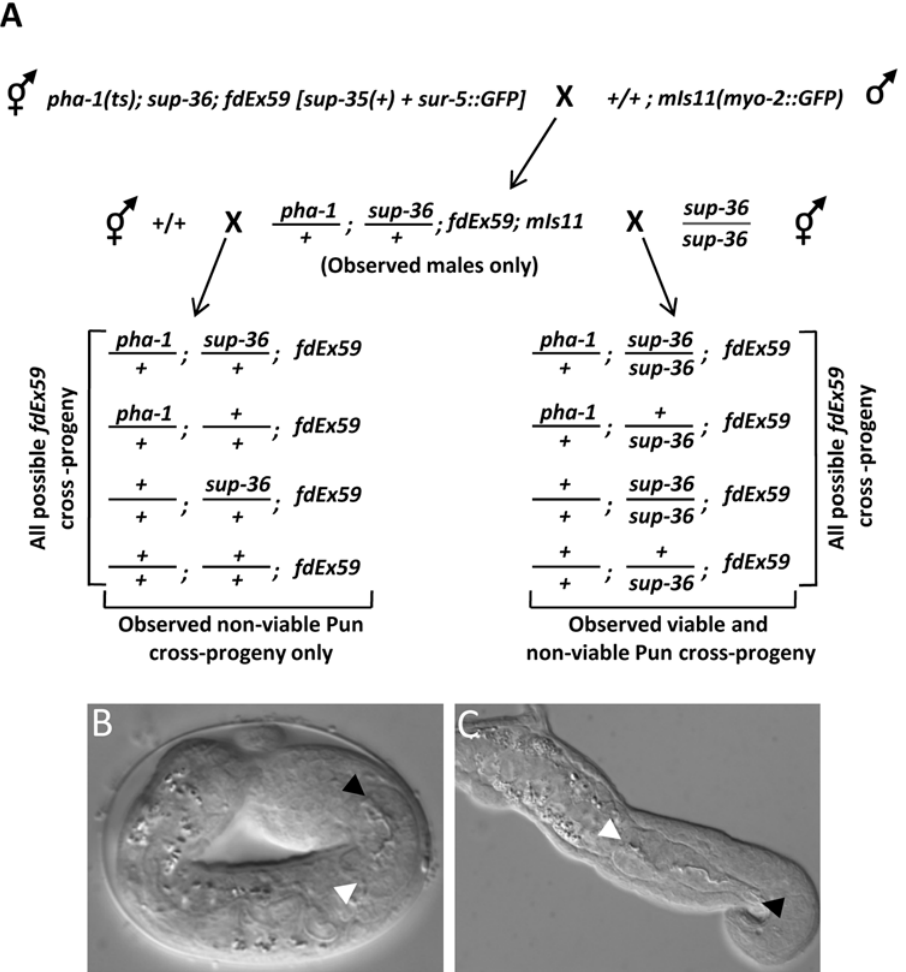
Figure 5. SUP-35 overexpression phenocopies pha-1 loss of function. (A) Representative genetic strategy applied to assay the effects of SUP- 35 overexpression in wild type and in sup-36 and sup-37 mutant backgrounds. Wild-type males carrying an integrated myo-2 ::GFP reporter ( mIs11 ) were crossed into pha-1 ; sup-36 hermaphrodites carrying a sup-35 -overexpressing extrachromosomal array (fdEx59) . Although this mating failed to produce viable F1 cross-progeny hermaphrodites, fertile cross-progeny males were generated, which were identified by expression of the myo-2 ::GFP reporter. F1 cross-progeny males were then mated to wild-type or sup-36 hermaphrodites, and cross-progeny were identified based on the myo- 2 ::GFP reporter. Mating into the N2 strain failed to produce viable cross-progeny males or hermaphrodites, whereas mating to sup-36 generated both viable and non-viable male and hermaphrodite F2 cross-progeny. Non-viable F2 cross-progeny from both matings displayed a Pun (Pharynx unattached) phenotype, and these animals uniformly carried the fdEx59 array. Identical results were also obtained for sup-37 mutants using the above strategy, and similar findings were obtained for both sup-36 and sup-37 using additional genetic approaches (see Materials and Methods). (B,C) DIC images of a typical non-viable embryo (B) and larva (C) obtained through the above mating. Note the Pun phenotype. Black and white arrowheads indicate the anterior and posterior pharyngeal boundaries, respectively. Scale bar in C, 1 m m for B,C.